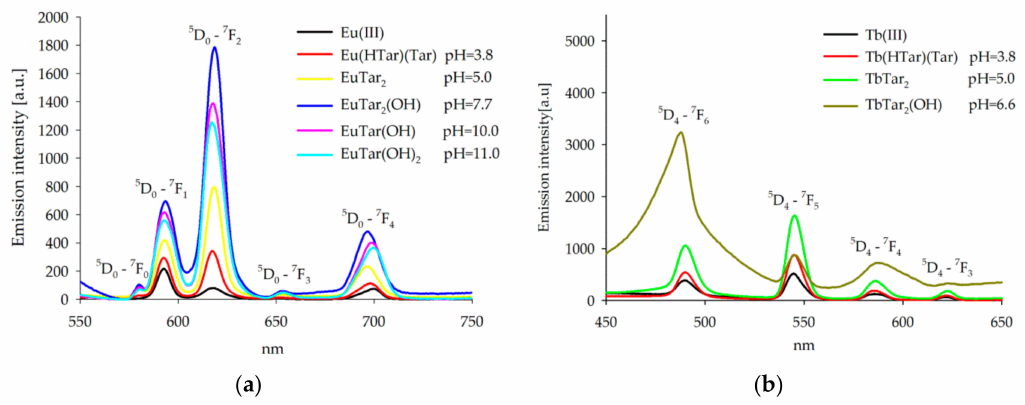
Figure 5. Changes in the emission spectra of the systems: ( a ) Eu(III) / Tar at pH 3.8, 5.0, 7.7, 10.0, and 11.00; ( b ) Tb(III) / Tar at pH 3.8, 5.0, and 6.6.